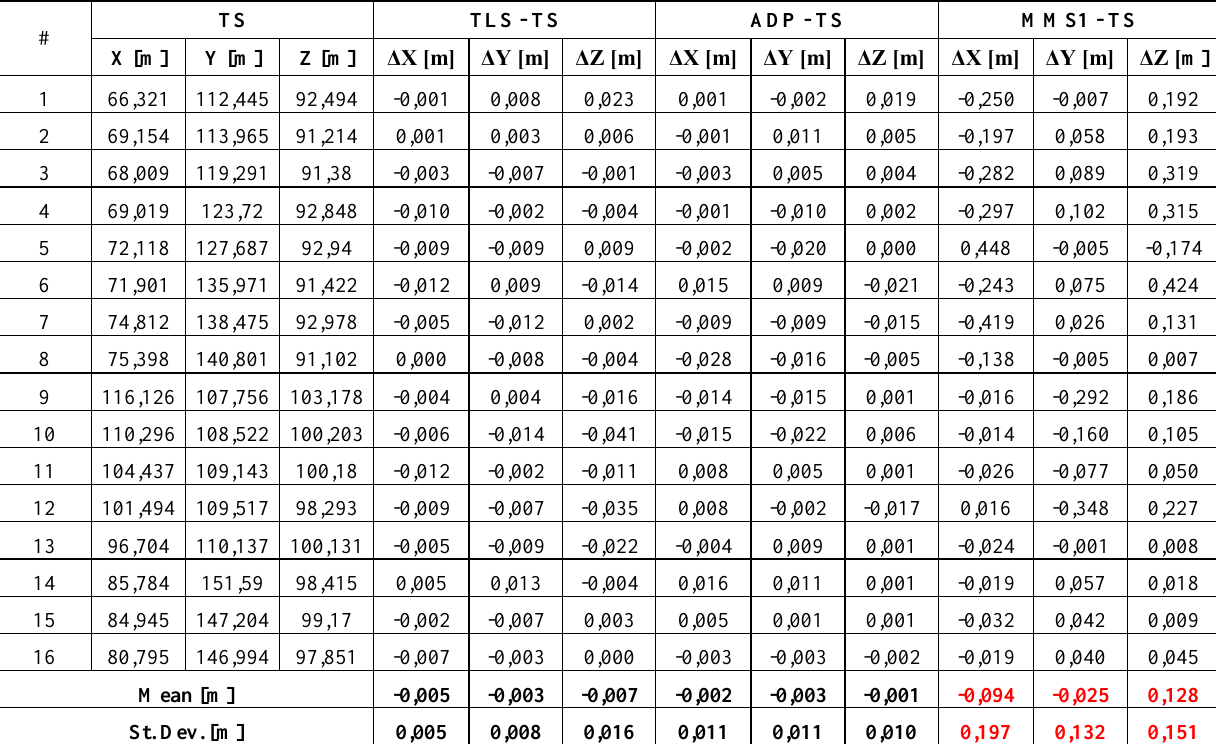
Table 5. Residuals of 3D coordinates on a set of signalized